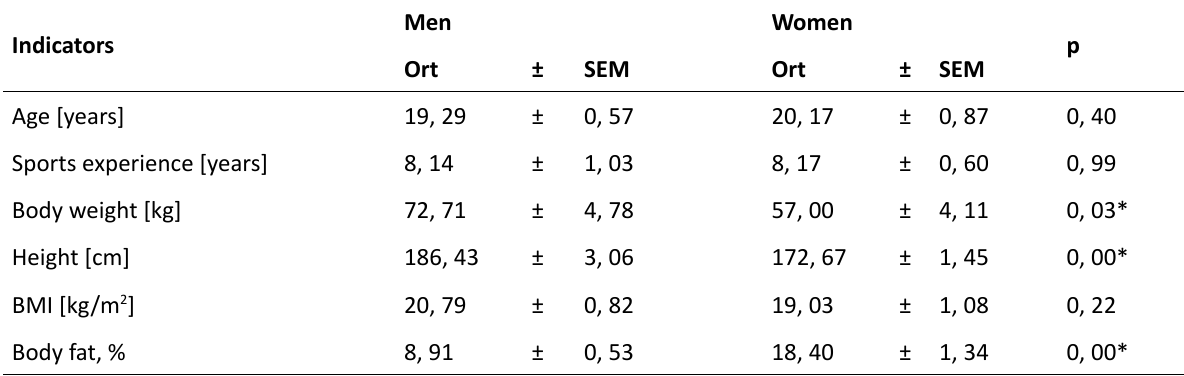
Table 1. Physical characteristics of subjects Indicators